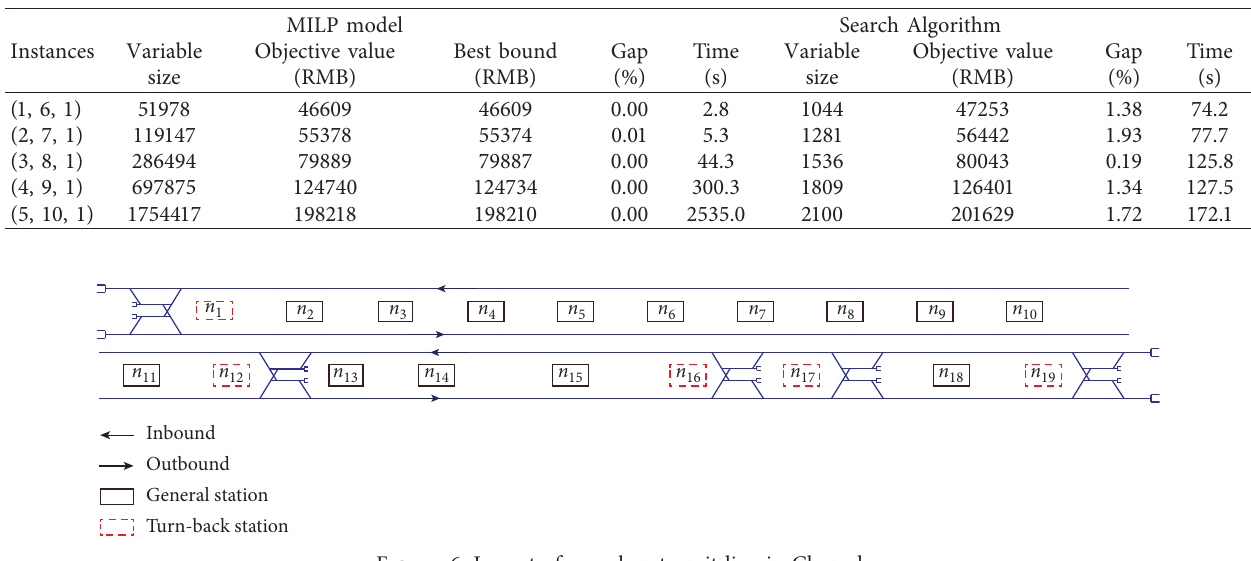
Figure 6: Layout of an urban transit line in Chengdu.